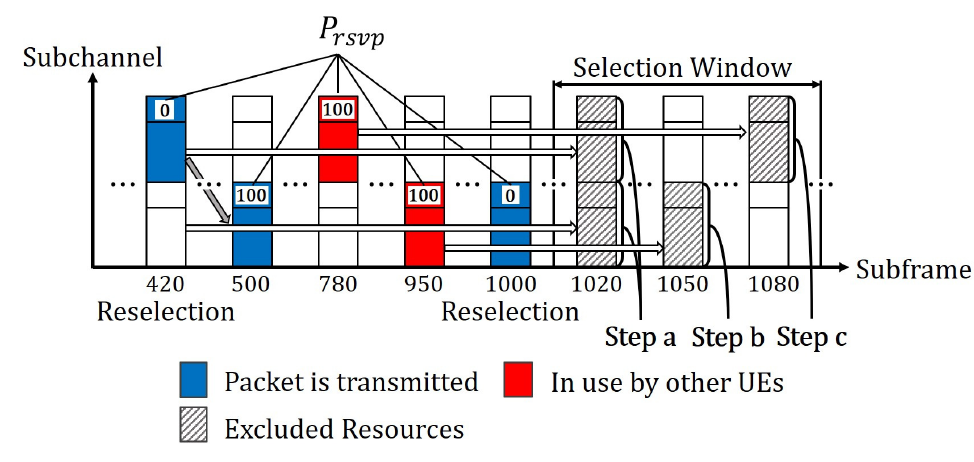
Figure 5. An example of exclusion by Steps a, b, and